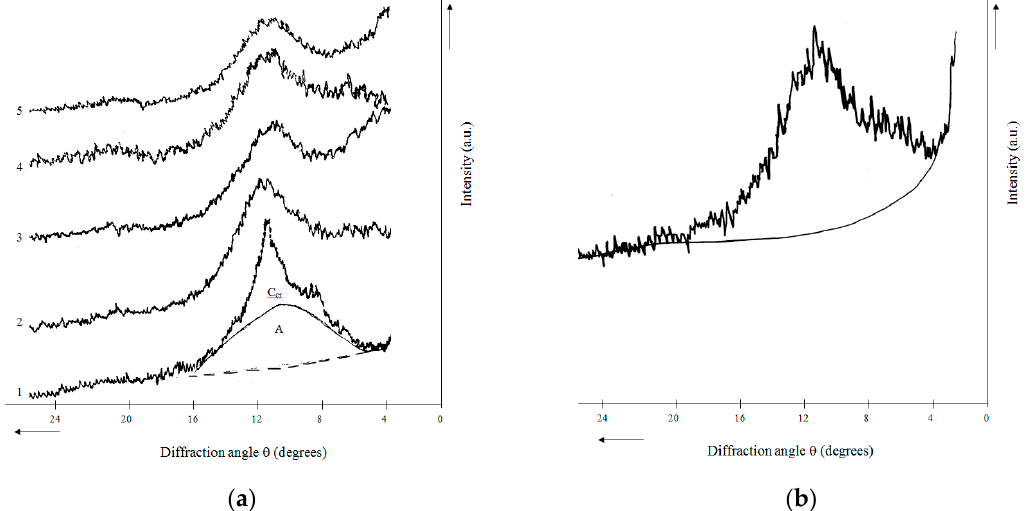
Figure 5. X-ray diffraction patterns of rice husk hydrolytic lignin and its carbonization products: ( a )